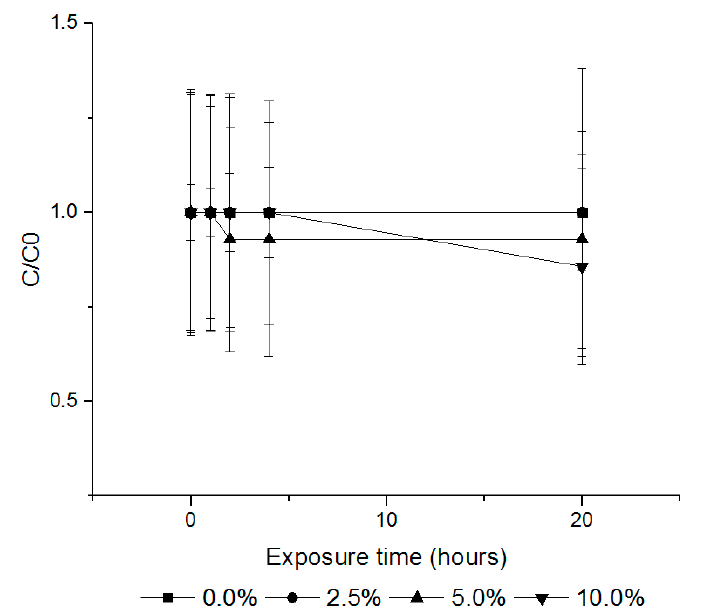
Figure 4. The loss amounts of PH 3 according to the different loading ratios of cured tobacco leaves (control, 2.5%, 5.0% and 10.0% ( w / v )) during fumigation for 20 h (20 ± 1 ◦ C). Each value represents the mean ± SE ( n = 3). C / C0 is the ratio of the concentration of the fumigant in the headspace.